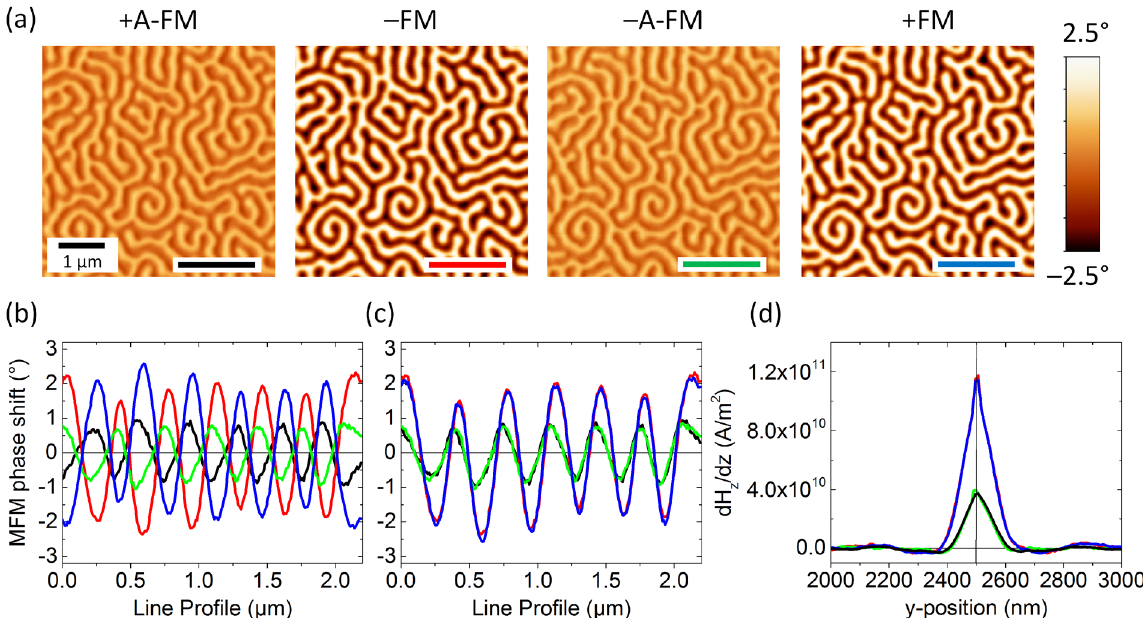
Figure 3. RSTTF of thin ML-MFM probe. ( a ) MFM phase shift measurements on the Co/Pt reference sample using the thin ML-MFM probe magnetised in the (left to right) + A-FM, − FM, − A-FM and + FM states, respectively. ( b ) MFM profiles obtained along the lines of the corresponding colour in ( a ). ( c ) Same MFM profiles as reported in ( b ), where the + A-FM and + FM profiles are inverted to be compared with the − A-FM and − FM states. ( d ) Real space tip transfer function of the four different magnetisation states (one-dimensional cut along the image y -direction, which is perpendicular to the cantilever